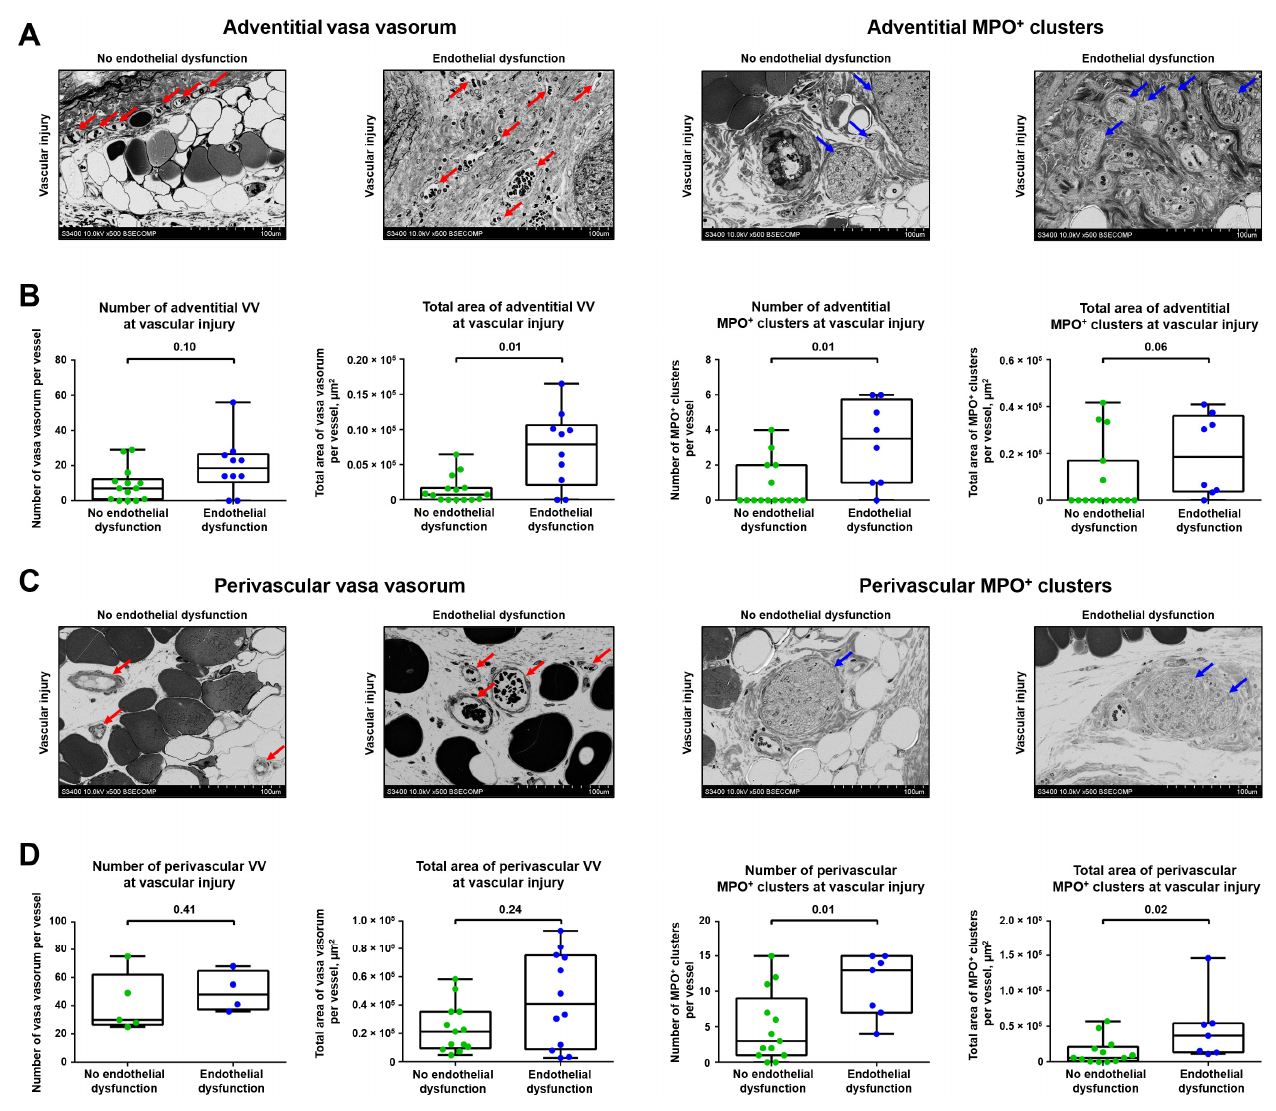
Figure 5. Endothelial dysfunction enhances sprouting of VV and growth of MPO + clusters. ( A ) Representative images showing adventitial VV and MPO + clusters in rats which underwent balloon angioplasty of the abdominal aorta and optional intravenous administration of CPPs, a trigger of endothelial dysfunction (900 µL of particles per injection, equal to 600 µg calcium) or equal volume of physiological saline for 5 days, followed by euthanasia upon 5 weeks. Red and blue arrows indicate VV and MPO + clusters, respectively. EM-BSEM, ×500 magnification (scale bar: 100 µm, accelerating voltage: 10 kV); ( B ) Quantitative analysis of number and area of adventitial VV and MPO + clusters in rats from the experiment in A. Each dot represents a cross-section of the epoxy resin-embedded aorta. Whiskers indicate range, box bounds indicate 25th–75th percentiles, center lines indicate median. p -values provided above boxes, Mann–Whitney U-test; ( C ) Representative images showing perivascular VV and MPO+ clusters in rats from the experiment in A. Red and blue arrows indicate VV and MPO + clusters, respectively. EM-BSEM, ×500 magnification (scale bar: 100 µm, accelerating voltage: 10 kV); and ( D ) Quantitative analysis of number and area of perivascular VV and MPO + clusters in rats from the experiment in ( A ). Each dot represents a cross-section of the epoxy resin-embedded aorta. Whiskers indicate range, box bounds indicate 25th–75th percentiles, center lines indicate median. p -values provided above boxes, Mann–Whitney U-test. VV—vasa vasorum, MPO—myeloperoxidase, CPPs—calciprotein particles, and EM-BSEM—embedding and backscattered scanning electron